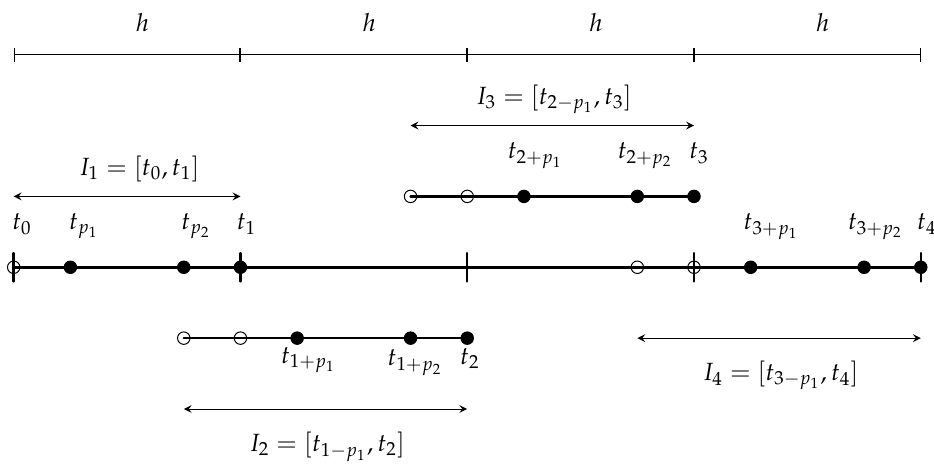
Figure 1. Illustration of the overlapping grid when N = 4 and m =